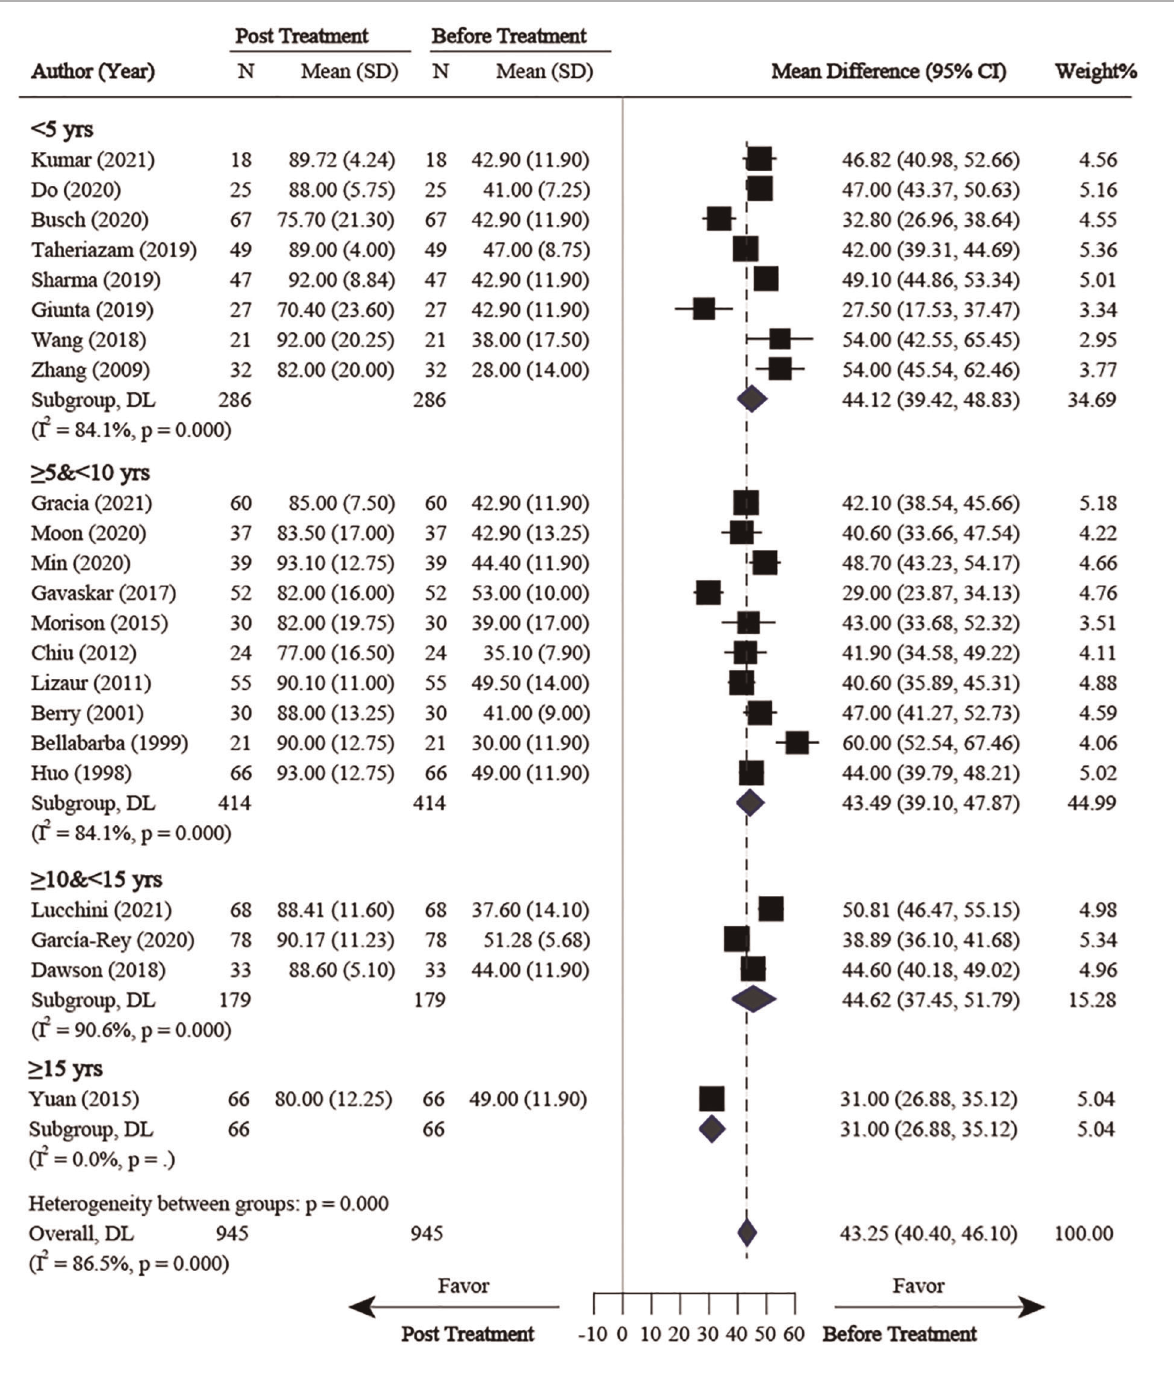
FIGURE 4 Meta-analysis for HHS comparison between posttreatment and pretreatment. HHS, harris hip score; SD, standard